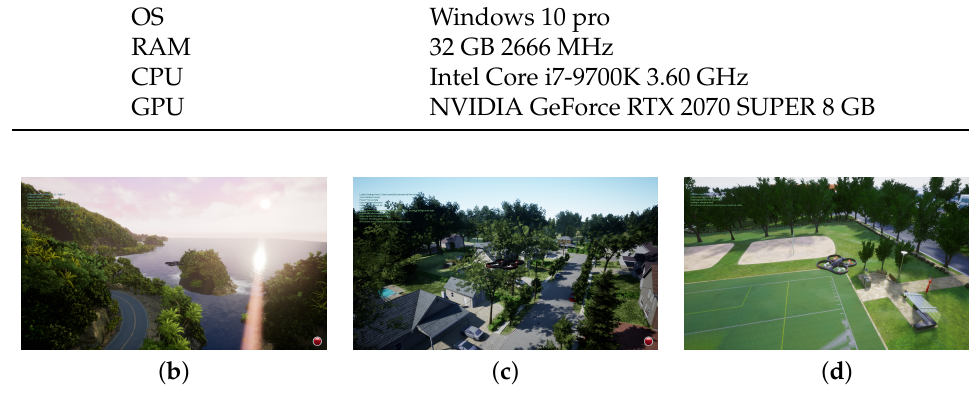
Figure 9. Appearance of the maps for training: ( a ) City environment, ( b ) Coastline, ( c ) Neighborhood, ( d ) Soccer